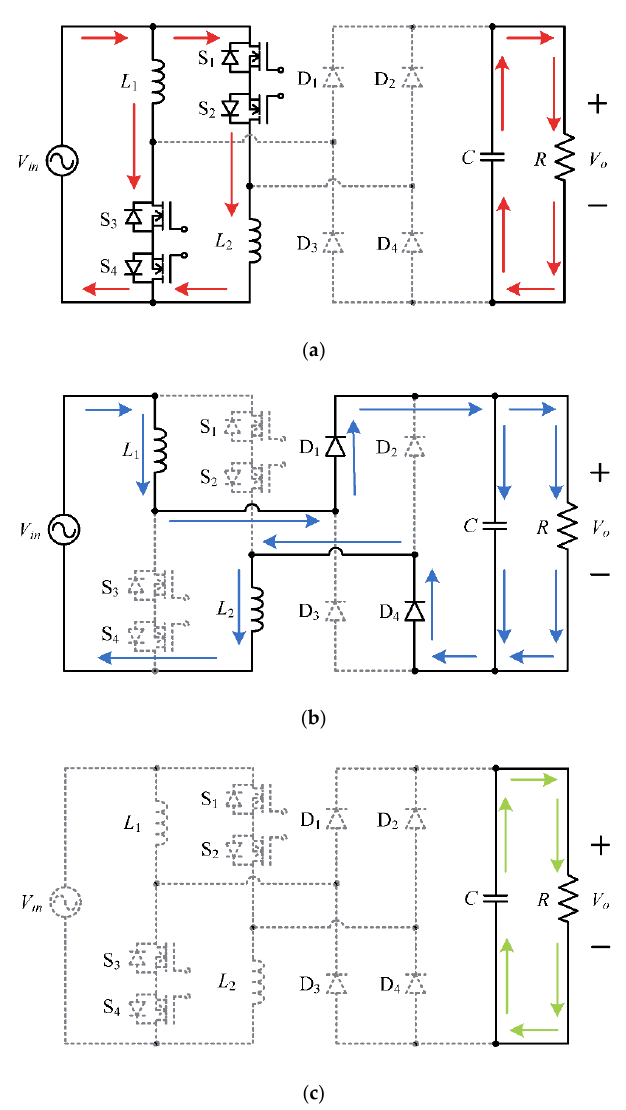
Figure 3. The operation modes of the proposed bridgeless high step-up voltage gain PFC converter in the positive line cycle: ( a ) mode I; ( b ) mode II and ( c ) mode III.